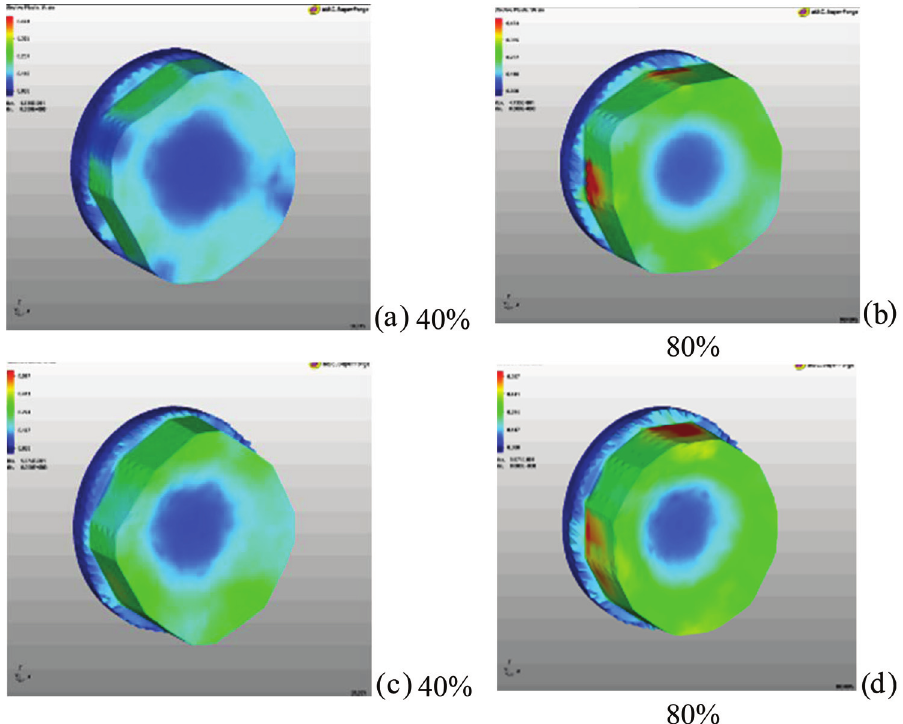
Figure 10: Picture of deformation intensity distribution when forging on RFM with angles of rotation 30° (a and b) and 60° (c and d), t ¼